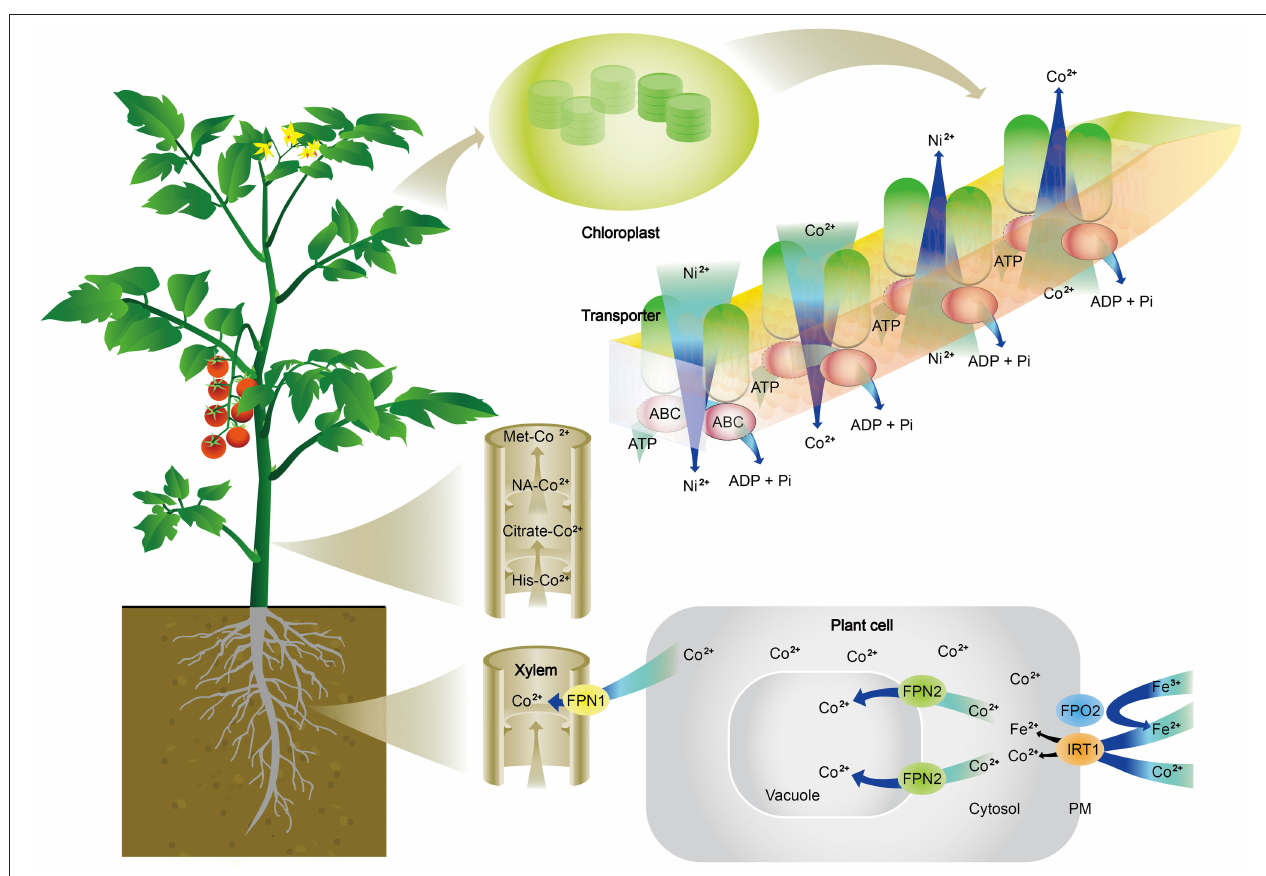
FIGURE 2 | Schematic illustration of cobalt (Co 2 + ) absorption, transport, and distribution in plants. Co 2 + is absorbed from the soil into epidermal cells of roots by an iron transporter (IRT1). Once Co 2 + is absorbed inside cells, Ferroportins (FPN1 and FPN2) are responsible for its further movement. FPN2 transports Co 2 + into vacuoles, resulting in the sequestration of Co in root cells. FPN1 is to load Co 2 + into the xylem. In the xylem, Co 2 + is complexed with citrate, histidine (His), methionine (Met), or nicotianamine (NA) to be translocated to shoots. Co 2 + is released in leaves and participate in metabolisms, which are often associated with nickel (Ni) and iron (Fe). It is shown here the Ni and Co movement in or out of chloroplasts through ATP-binding cassette (ABC) transporter in the mediation of ionic homeostasis in the chloroplast.